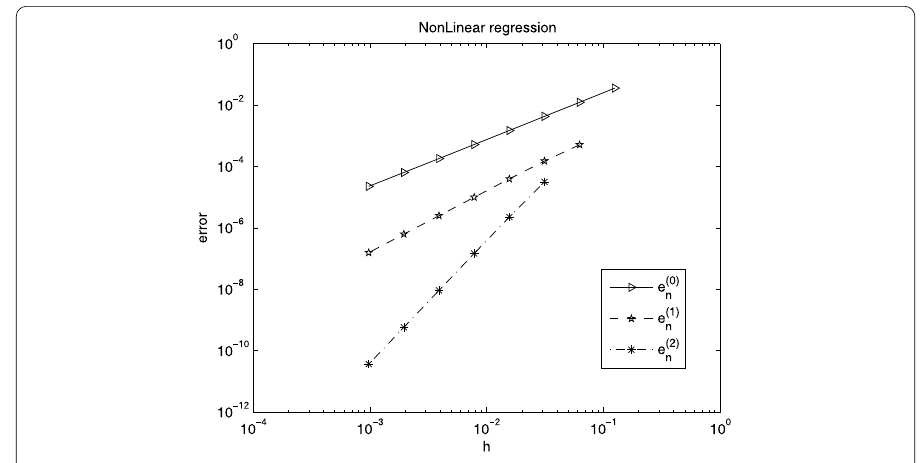
Figure 1 Nonlinear regression analysis at t = 0.25. Note that the order of convergence matches the error analysis and the order is clearly improved by using an extrapolation.